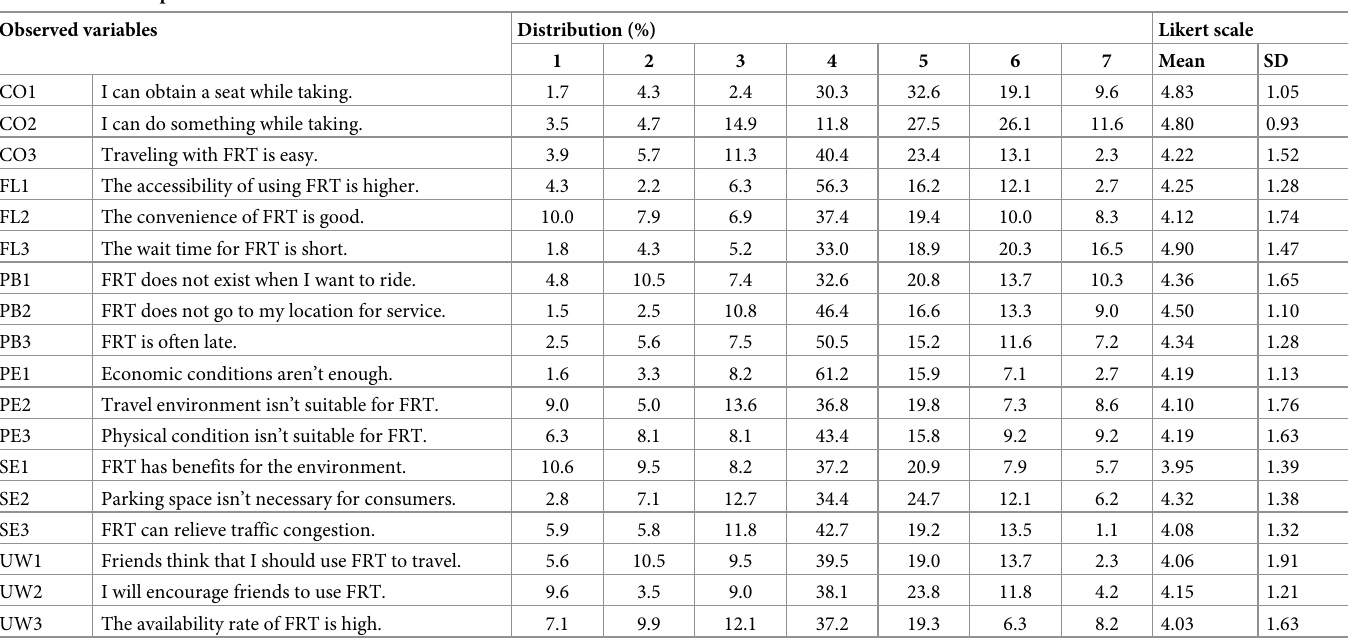
Table 2. The description of observed variables.